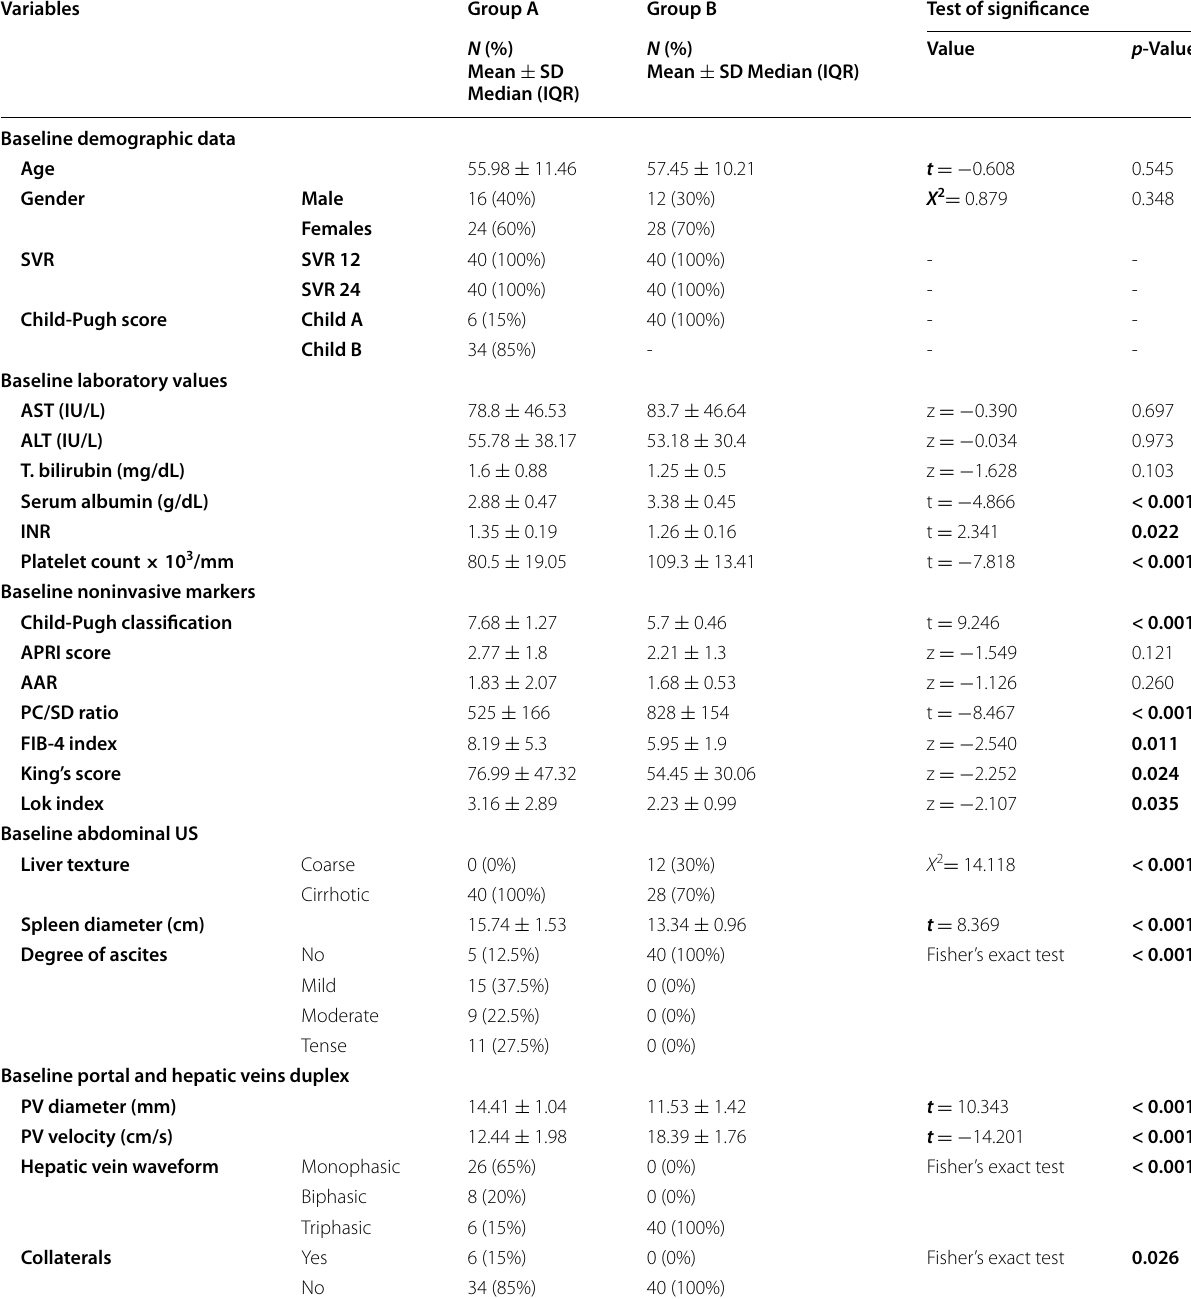
Table 1 Baseline characteristic data of the studied groups